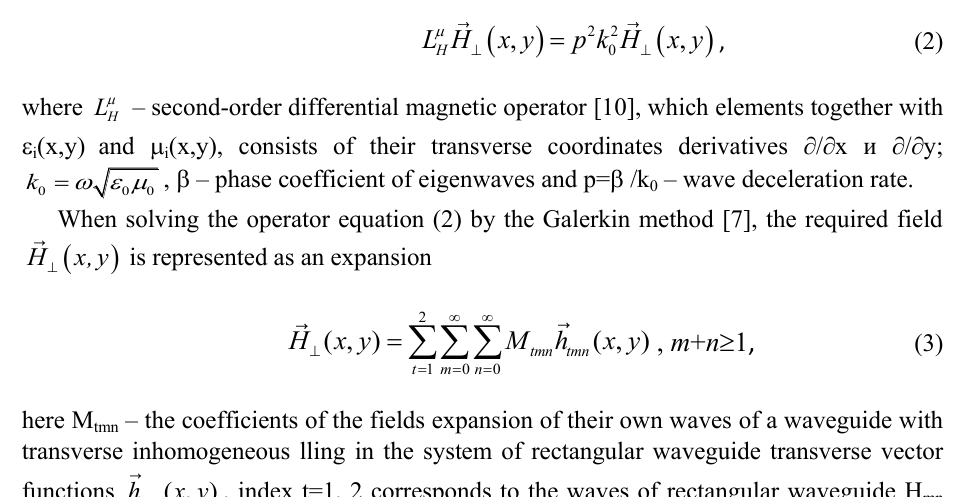
Fig. 2. Waveguides with transversely inhomogeneous ferrite-dielectric filling. After the vector E and component H are excluded from the system of equations (1), z the problem is reduced to solving a system of differential equations ob the transverse vector of the magnetic